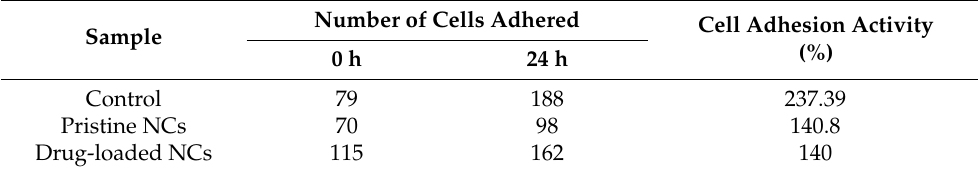
Table 3. Cytotoxicity of antibacterial NCs to cultured A549 cells.